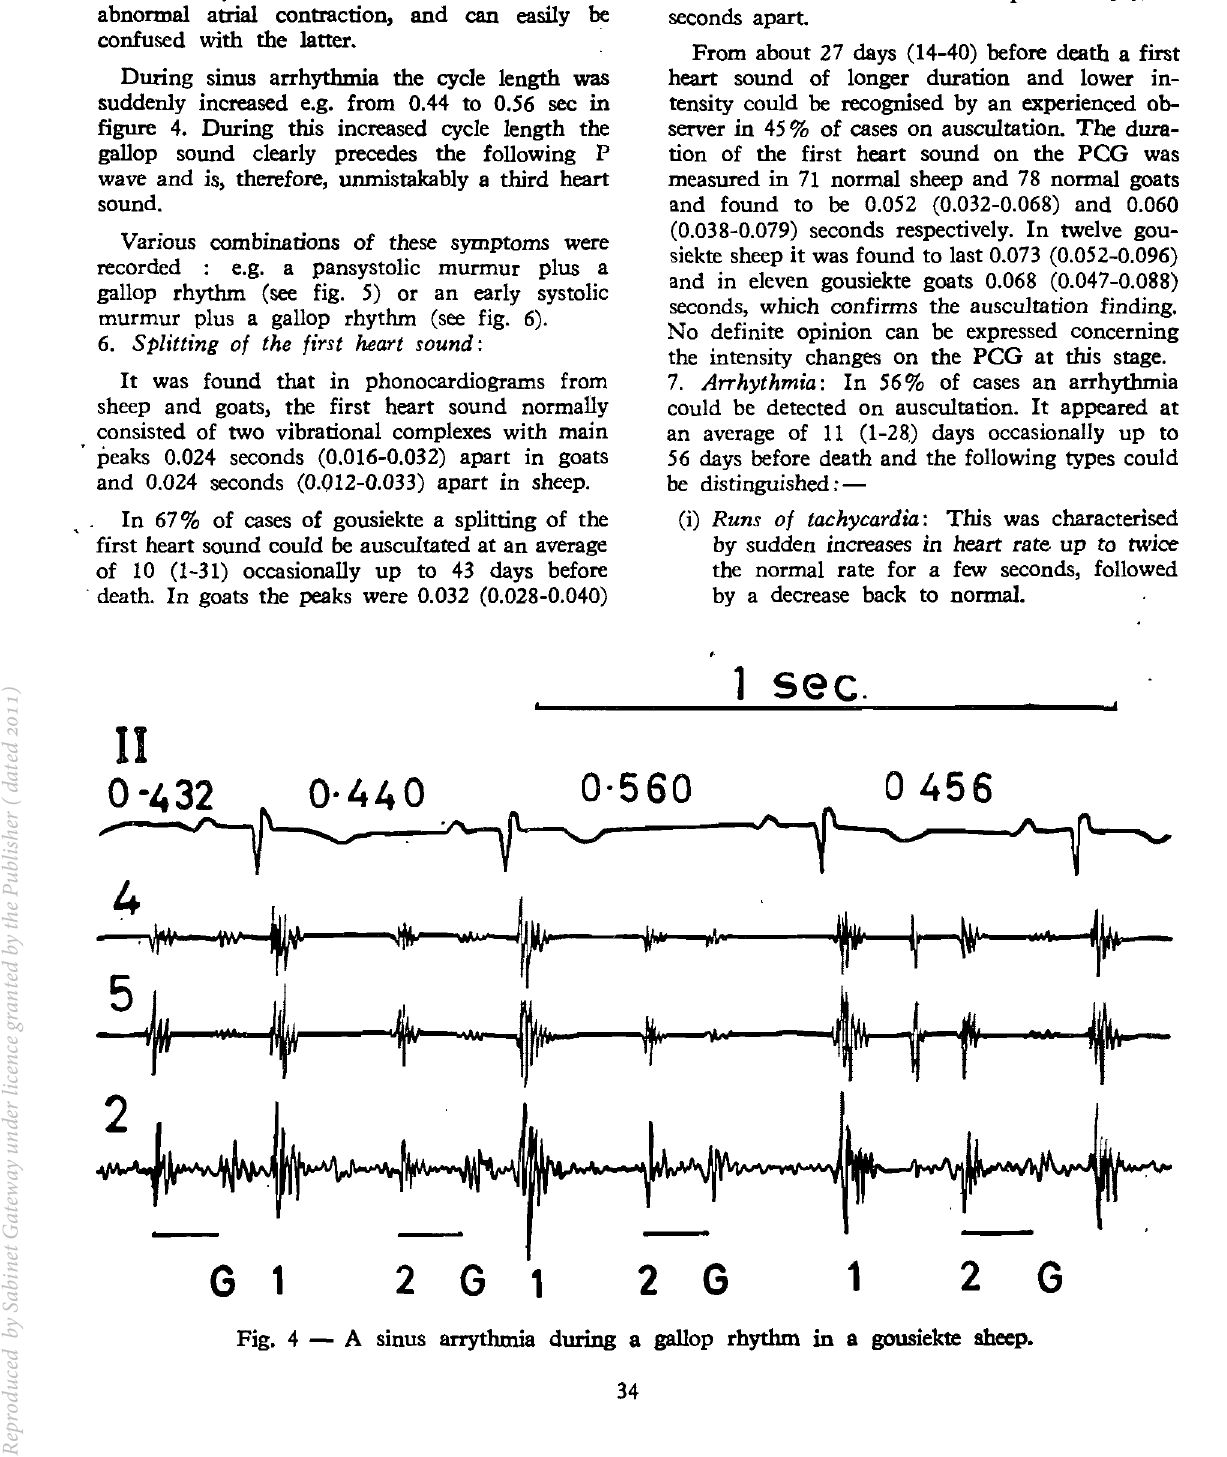
Fig. 4 - A sinus arrythmia during a gallop rhythm in a gousiekte